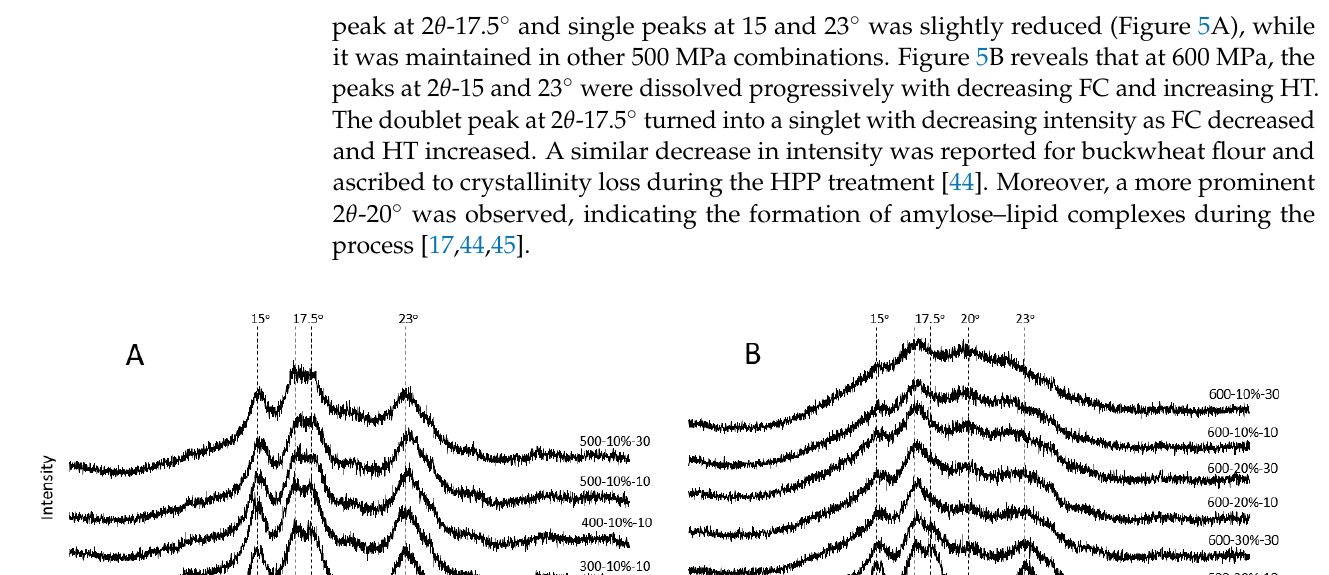
10 of 17 Figure 4. The relative crystallinity percentage (%RC) of untreated (0.1 MPa) and HPP-treated cassava flour at 10 min ( A ) and 30 min holding time ( B ). Error bars represent ± standard deviation (n = 3).